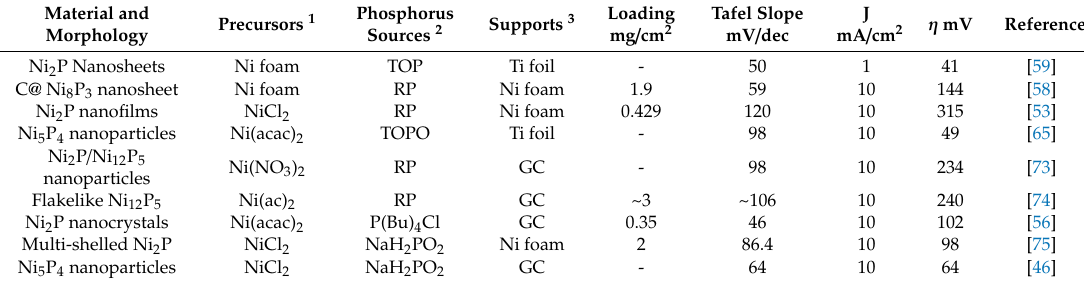
Table 2. Summary of the nickel phosphide electrocatalysts prepared through a solution-phase method for HER in alkaline